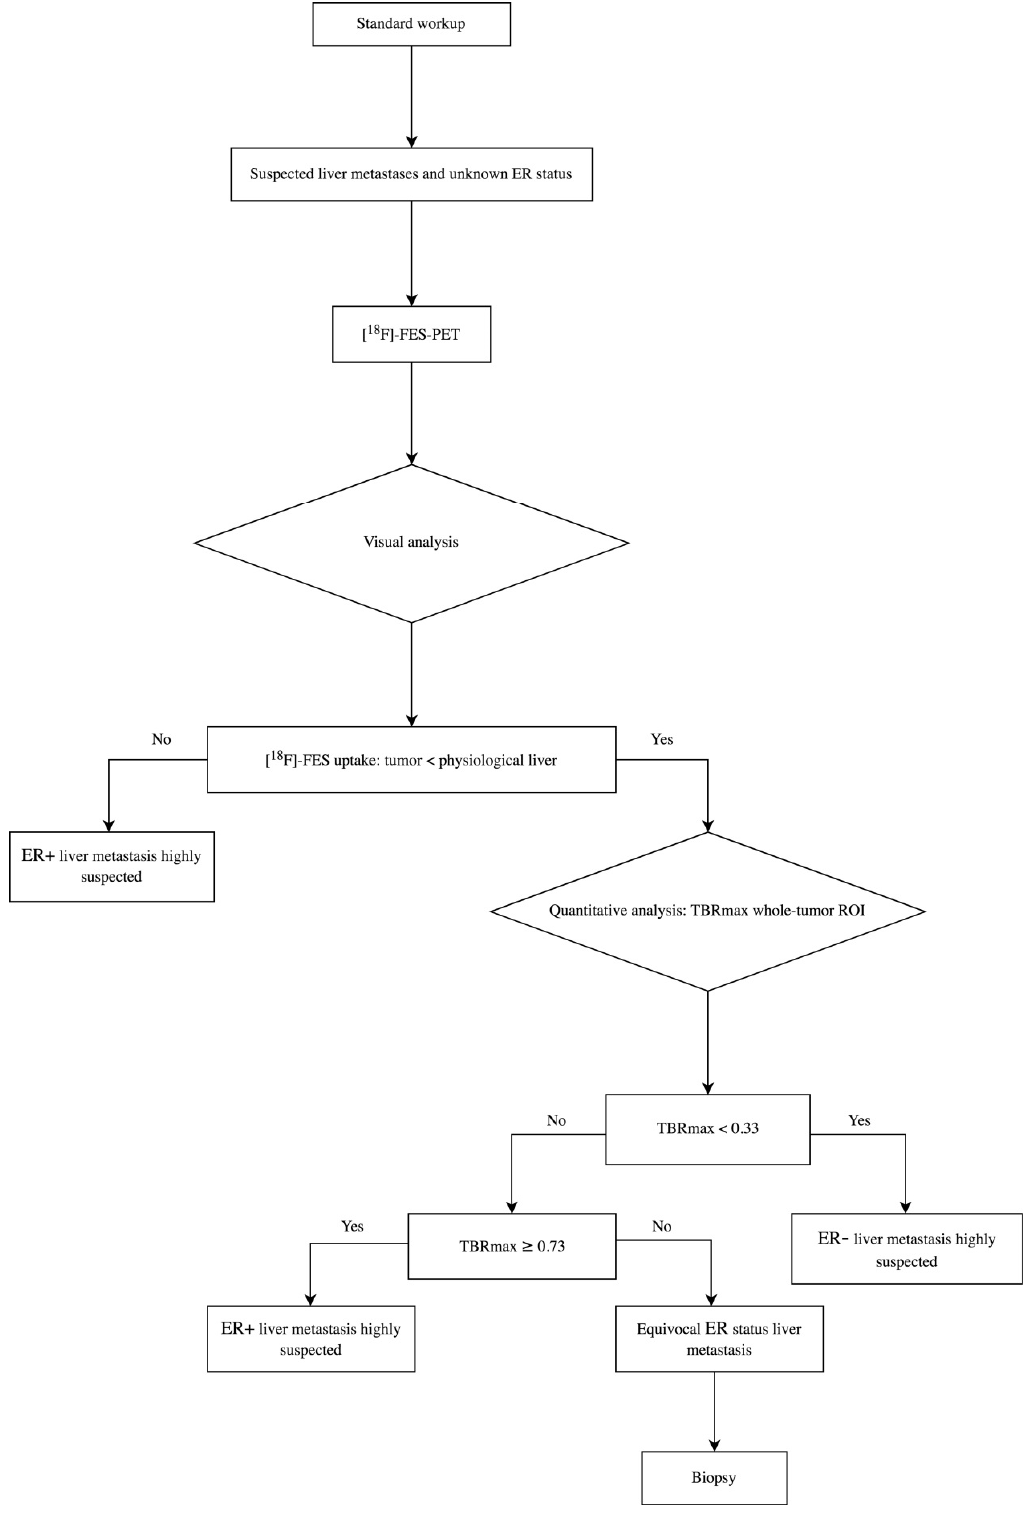
Figure 5. Decision flowchart: [ 18 F]-FES-PET to define ER expression in liver metastases. Abbreviations: ER = estrogen receptor; TBR = tumor-to-background ratio; ROI = region-of-interest. In 87% of the patients, the liver metastasis was visible on [ 18 F]-FES-PET as a lesion with lower tracer uptake than the surrounding liver. In the other cases, the lesion was not visible due to similar [ 18 F]-FES uptake as background liver activity. Our visual analysis is